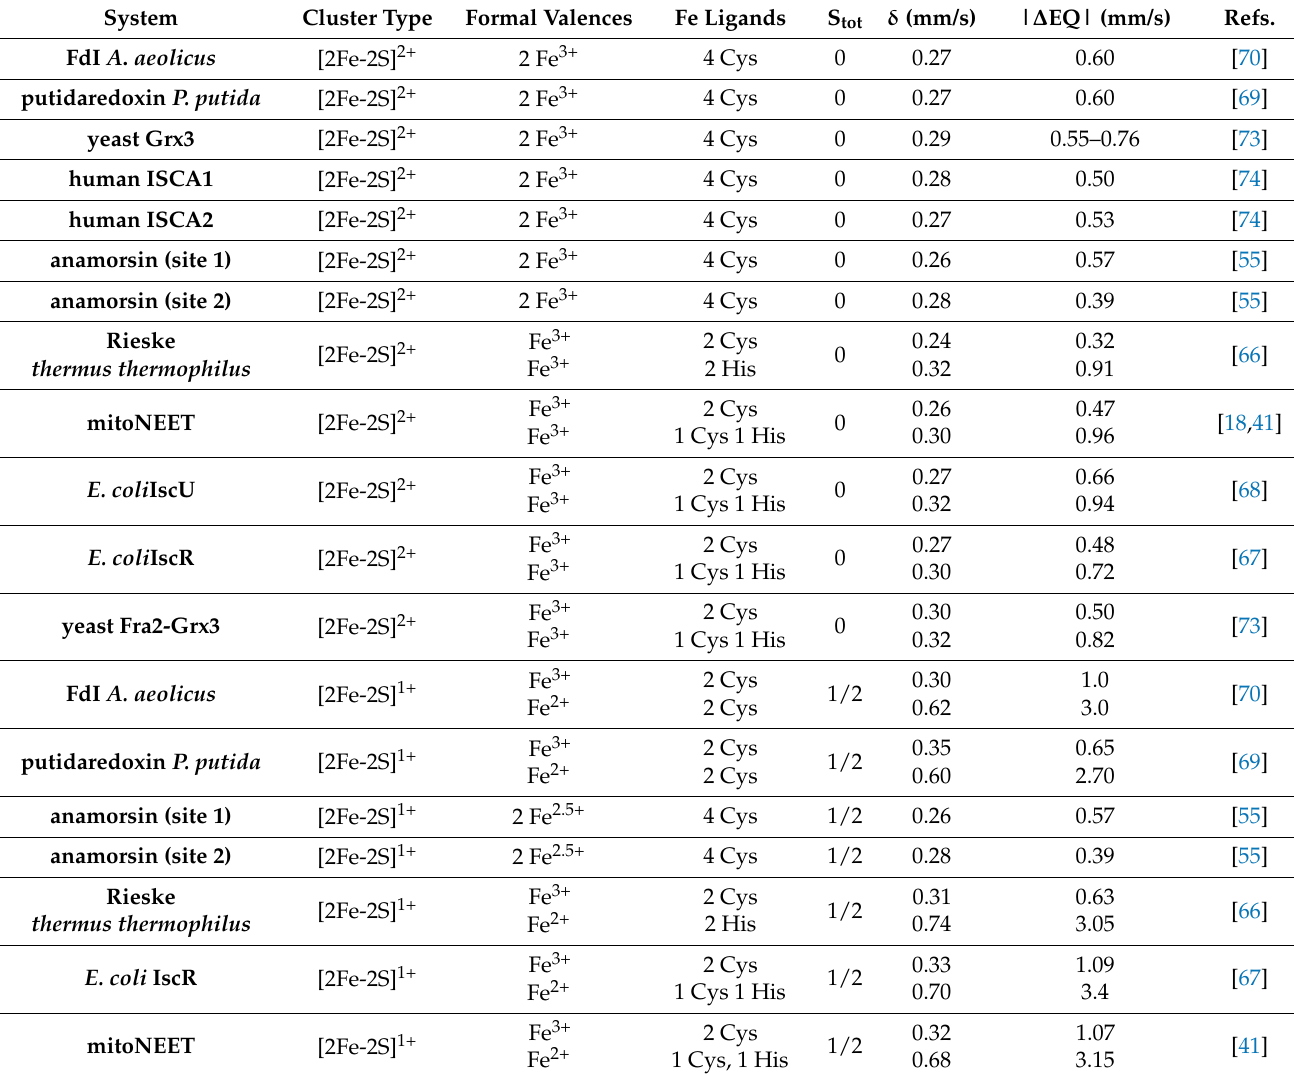
Table 1. Mossbauer parameters for selected [2Fe-2S] 2+ and [2Fe-2S] +